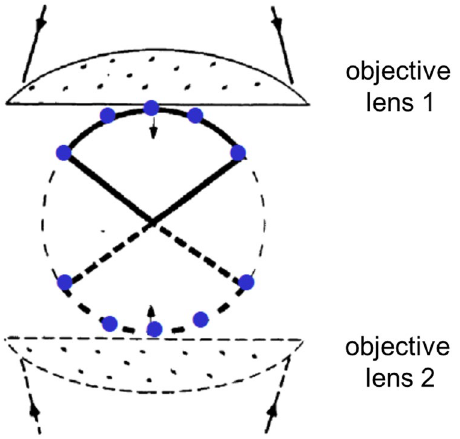
Figure 10. Schematic presentation of the arrangement used to calculate the focal intensity distribution in the case of “conventional” 4Pi microscopy. The drawing in black shows the case of “conventional” 4Pi microscopy, using two opposite high numerical aperture objective lenses 17 : In conventional far-field light microscopy only a segment of a spherical wave front is focused into or collected from an object point (indicated by the bold line, objective 1). A higher spatial resolution is achieved when not only a segment but a complete spherical wavefront is used (full 4 π solid angle, broken thin line). However, focusing or collecting is already improved substantially (along the optical axis) when a second lens provides another segment (broken bold line) of the complete spherical wave front thus increasing the angles of the focused and/or collected wave. The blue “dots” schematically show the spatial distribution of the light sources S i (Fig. 1) to simulate the conventional 4Pi case. The light sources with the largest angle towards the optical axis indicate the solid angle of the area containing the light sources with the collimated beams. Modified from Hell et al . 17